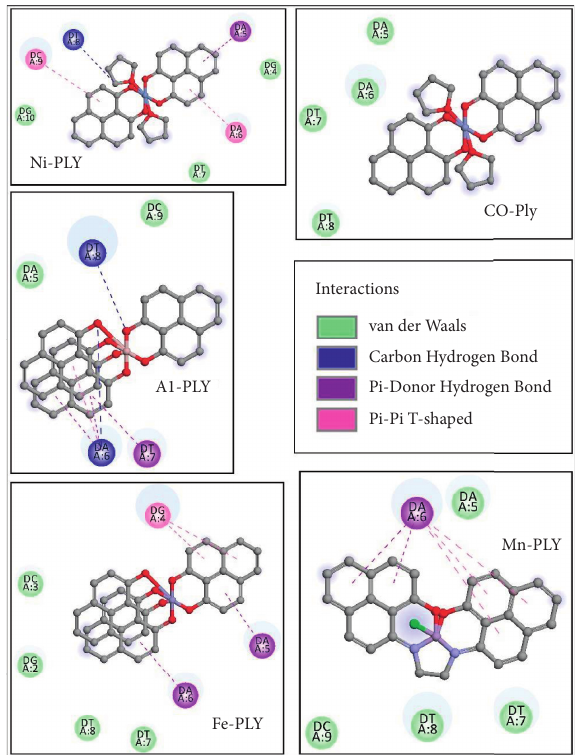
Figure 8: Binding interactions of metal-PLY with